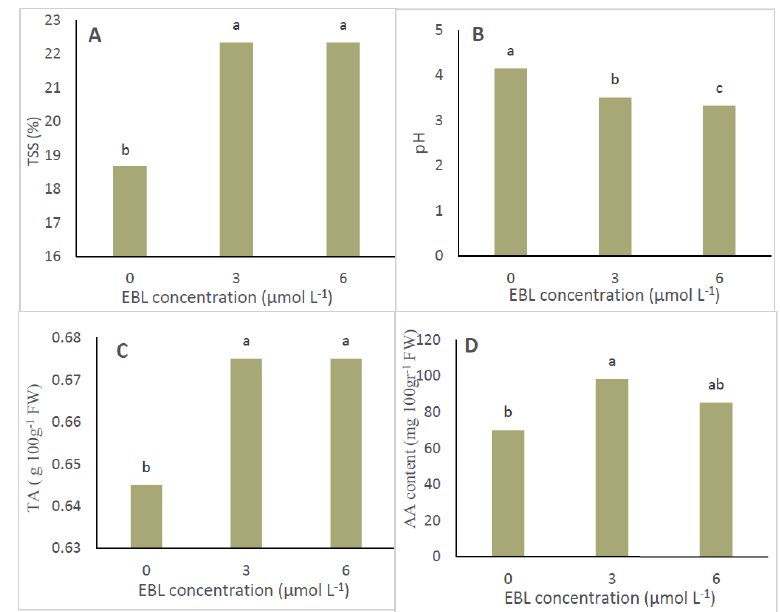
Fig. 1: Effect of EBL treatment on total soluble solid (TSS) content (A), pH (B), total acidity (TA) (C) and ascorbic acid (AA) content (D) in ‘Thompson seedless’ table grape. Different lowercase letters indicate the significance difference between the means (r=5) according to Duncan’s Multiple Range Test